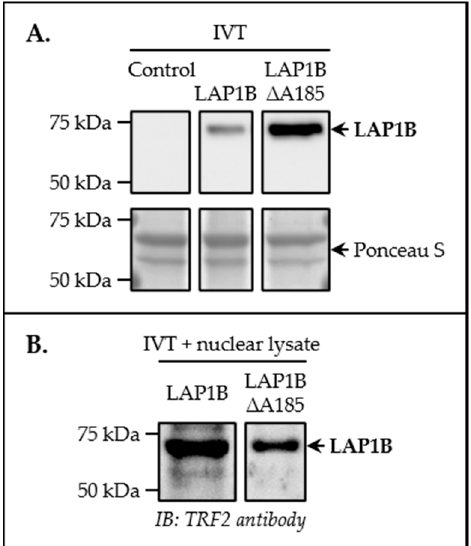
Figure 1. Validation of in vitro LAP1:TRF2 complex formation. ( A ) Successful in vitro translation of LAP1B variants. The membrane comprising IVT-derived samples of a negative control (i.e., empty vector) (left), full-length LAP1B (middle) and the shorter variant LAP1B ∆ A185 (right) were incubated with a LAP1-specific antibody to confirm the presence of LAP1B in both LAP1B–IVT and LAP1B ∆ A185–IVT samples. Ponceau S staining was used as protein loading control. ( B ) Blot overlay assay. The membrane containing LAP1B–IVT (left ) and LAP1B ∆ A185–IVT (right) samples was overlaid with HeLa